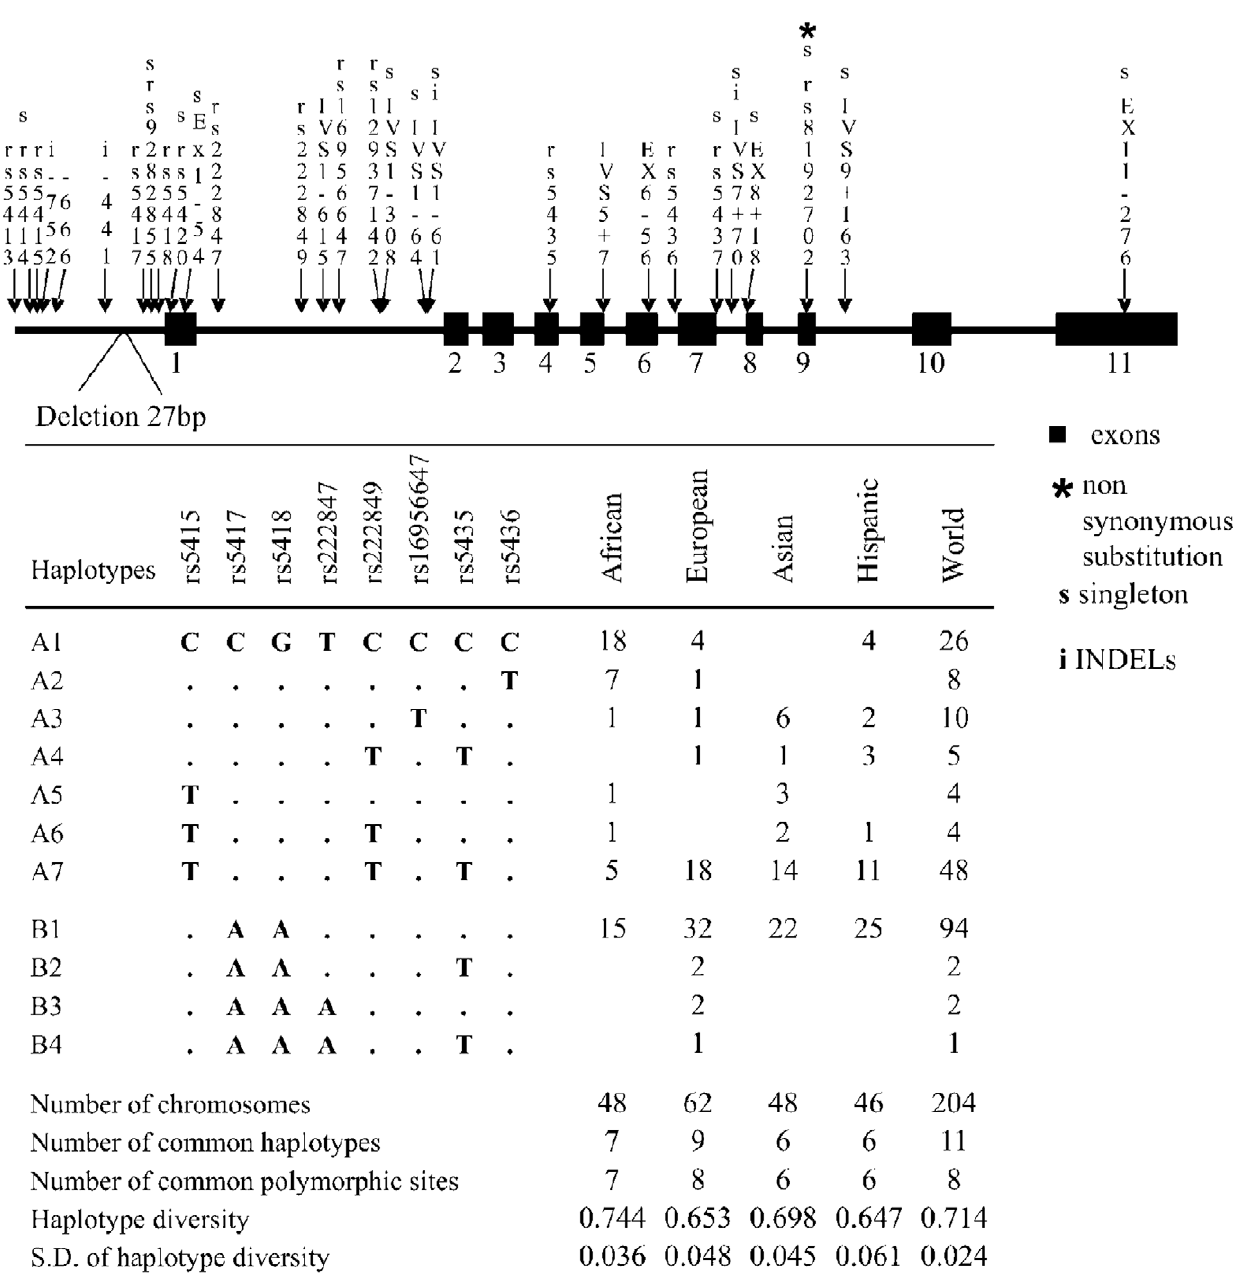
Figure 1. Genomic structure of SLC2A4, substitutions found, inferred haplotypes and their frequencies. Substitutions are represented by arrows and when no dbSNP name is available, named as in the SNP500Cancer database. A total of 29 polymorphisms (25 SNPs and 4 INDELs) were detected in the 204 worldwide re-sequenced chromosomes. Forty five percent of the substitutions were singletons and only 8 reached a MAF . 0.05 in at least one studied population. Comparison with the homologous chimpanzee sequence suggests that for all SNPs the ancestral allele is modal in humans. In the human genome, there is a 27 bp fixed deletion 348 bp upstream of the transcription initiation site. Three non-coding SNPs are in evolutionarily conserved positions (UCSC Genome Browser, [33]): rs5415 (conservation score: 0.96), within the promoter region, as well as rs222847 and rs222849, both with conservation score of 0.99 and within the first intron. Only one of the 4 coding-SNPs is non-synonymous (rs8192702, Ala358Val, a conservative substitution in exon 9, in the ninth trans-membrane domain), observed in a European. Haplotypes are inferred using only the 8 common SNPs.